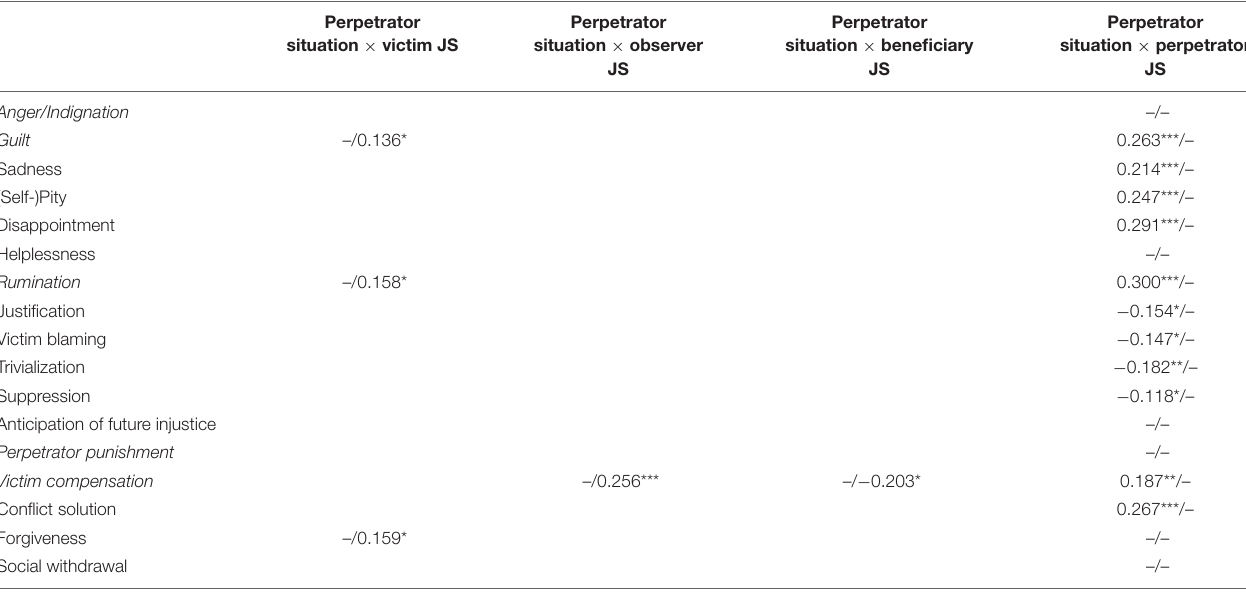
TABLE 8 | Prediction of responses in situations from the perpetrator’s perspective by the JS facets when including only perpetrator JS/all